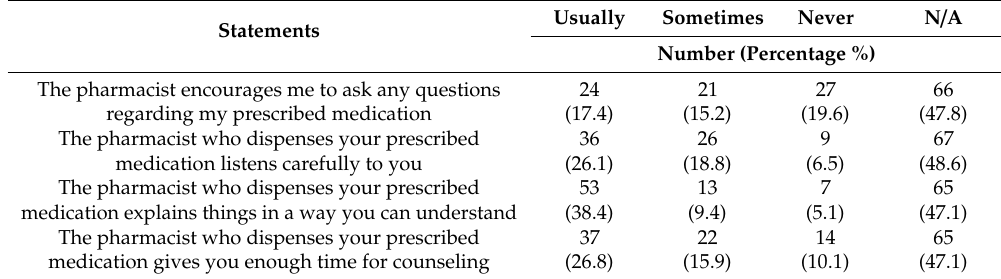
Table 7. Behaviors of the pharmacist counseling